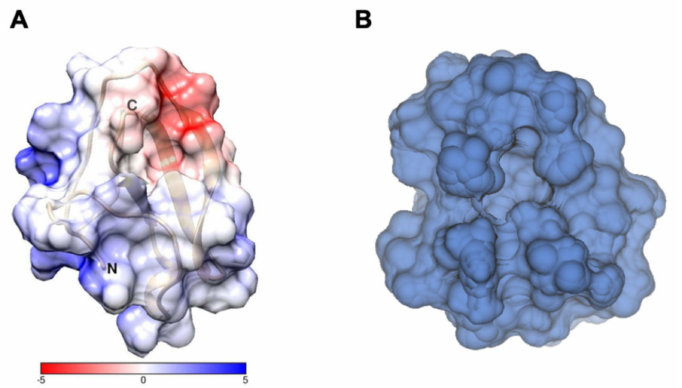
Figure 10. ( A ) Electrostatic potential surface of PAFC, as calculated [48] from the 6TRM structure deposited in pdb. Red means negative, and blue means positive surfaces. The scale is in kJ/mol/e. ( B ) Front view of cavity B of PAFC, formed predominantly by residues 3, 12, 13, 14, 28, 29, 30, 31, 33, 34, 35, 36, 44, 45, and